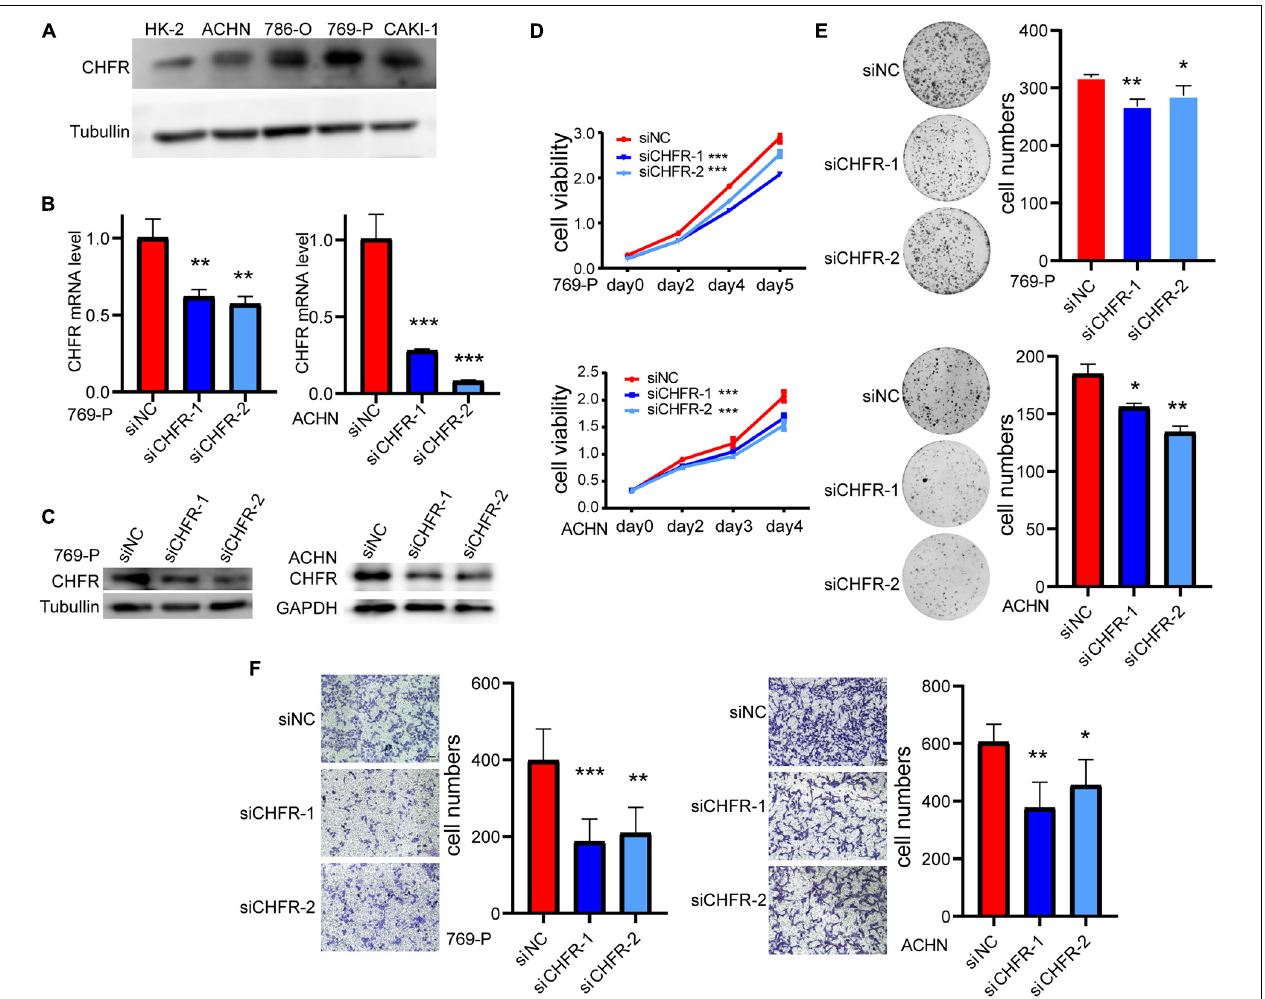
FIGURE 4 | Depletion of CHFR suppresses ccRCC growth and metastasis: (A) Western blot: CHFR protein level was higher in ccRCC carcinoma cells than that in normal kidney cell line HK-2. (B,C) The knockdown efficiency of CHFR in 769-P and ACHN cells transfected with CHFR siRNA or control siRNA was verified by RT-PCR assay and Western blot assay. (D) CCK8 assay of ACHN and 769-P cells transfected with CHFR siRNA or control siRNA. The proliferation rates transfected with siCHFR were significantly lower than the control cells. (E) Colony formation assay. CHFR knockdown suppressed the colony formation. (F) Transwell assays were used to evaluate cell migration ability. Scale bar: 100 µ m. All values are expressed as the mean ± SD (* p < 0.05, ** p < 0.01, *** p <